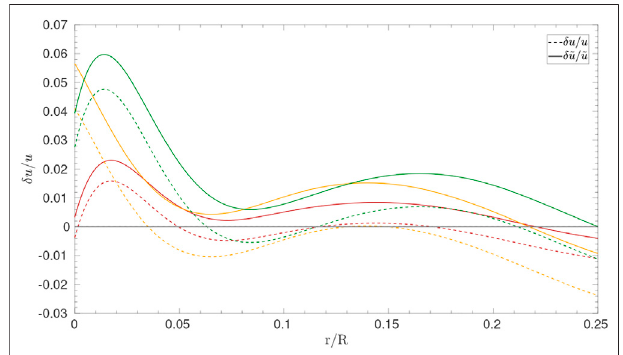
FIGURE 5 | Differences between the dimensional (( u ), dashed line) and dimensionless ( ~ u , plain line) squared isothermal sound speed for models of 16CygA from Farnir et al. (2020). The differences are those computed in Buldgen et al. (2022), Figure 13A and are linked to models of 16CygA showingdifferencesintheirmeandensityvaluesbetween1(orangeandgreen lines) and 2% (red